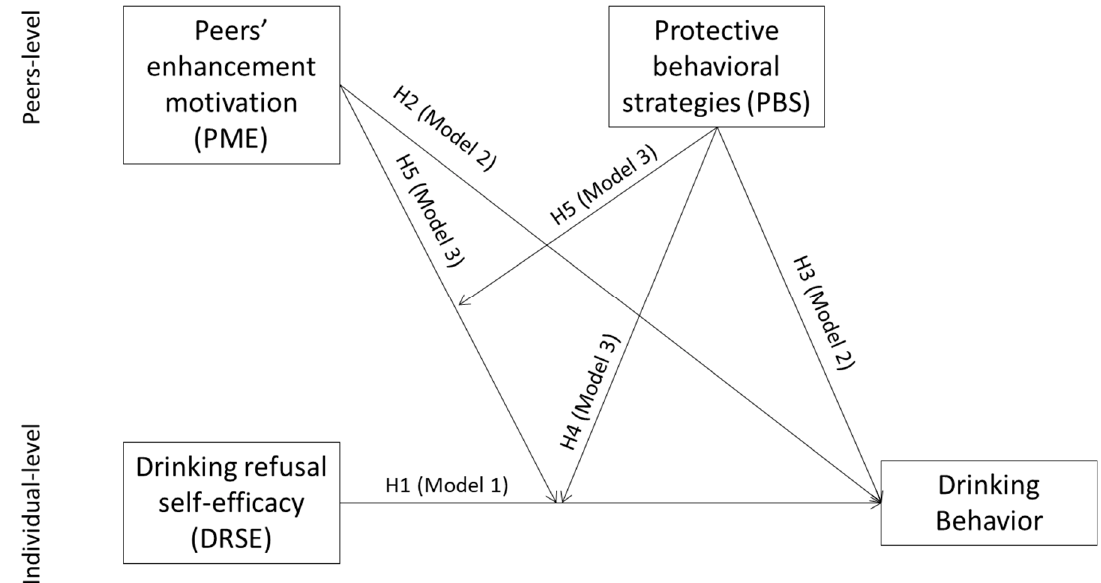
Figure 1. In model 1, the individual variable (drinking refusal self-efficacy, Hl) is a predictor of drinking behavior. In model 2, the collective-level variables (peers’ enhancement motivation, H2; peers’ protective behavioral strategies, H3) are considered predictors of drinking behavior. In model 3, the two- way interaction peers’ protective behavioral strategies with drinking refusal self-efficacy (H4) are inserted as predictors of drinking behavior; and the three-way interaction peers’ enhancement motivation with peers’ protective behavioral strategies and drinking refusal self- efficacy (H5) are added as predictors of drinking behavior.